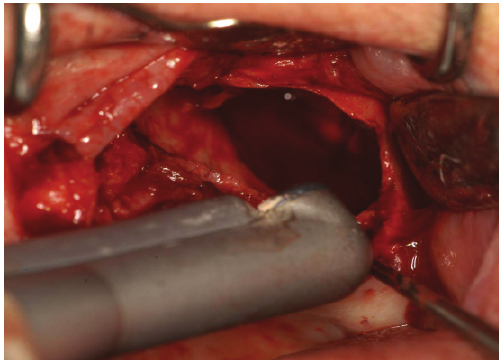
Figure 4: Bone resection and corticotomy with Er:YAG laser (Step 2): Er:YAG laser vaporization of bone with mirror handpiece (R02) used at distance; visible is the sinus involvement.